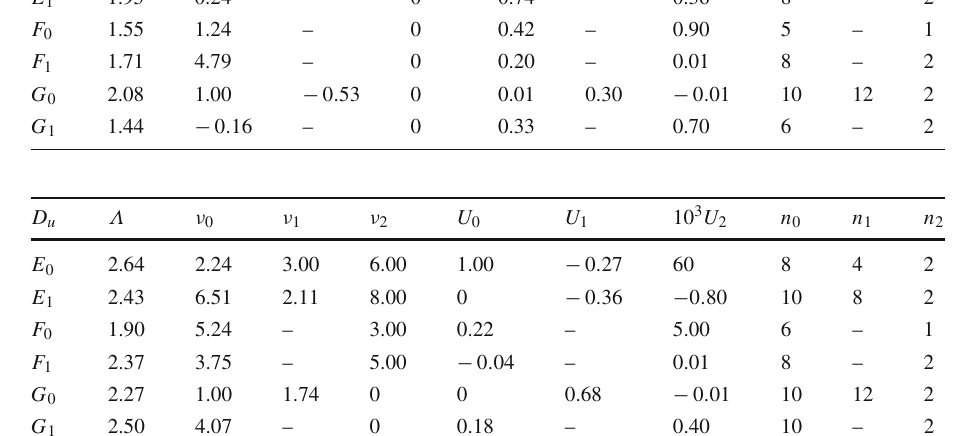
Table 7 Parameters of the BSA representation in Eq. (67) for the kaon